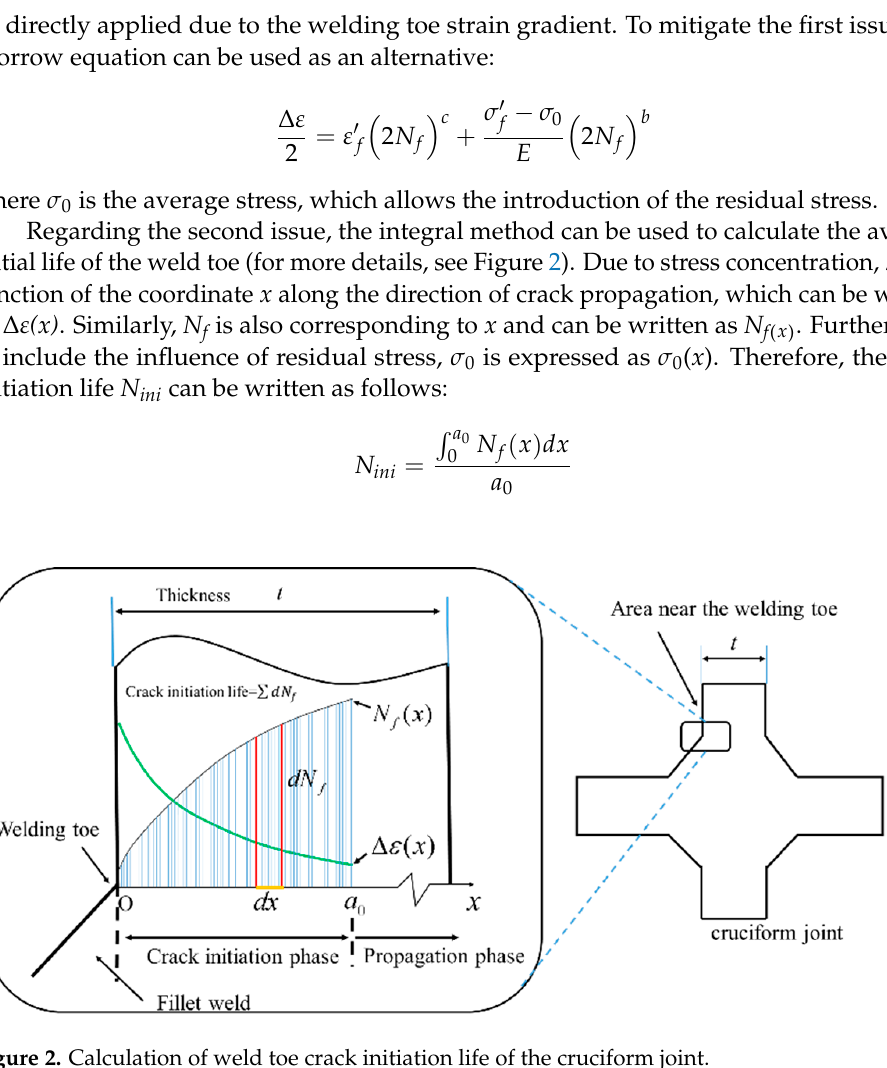
N f cannot be analytically solved as a function of ∆ ε by Equation (2), therefore, N f (x)